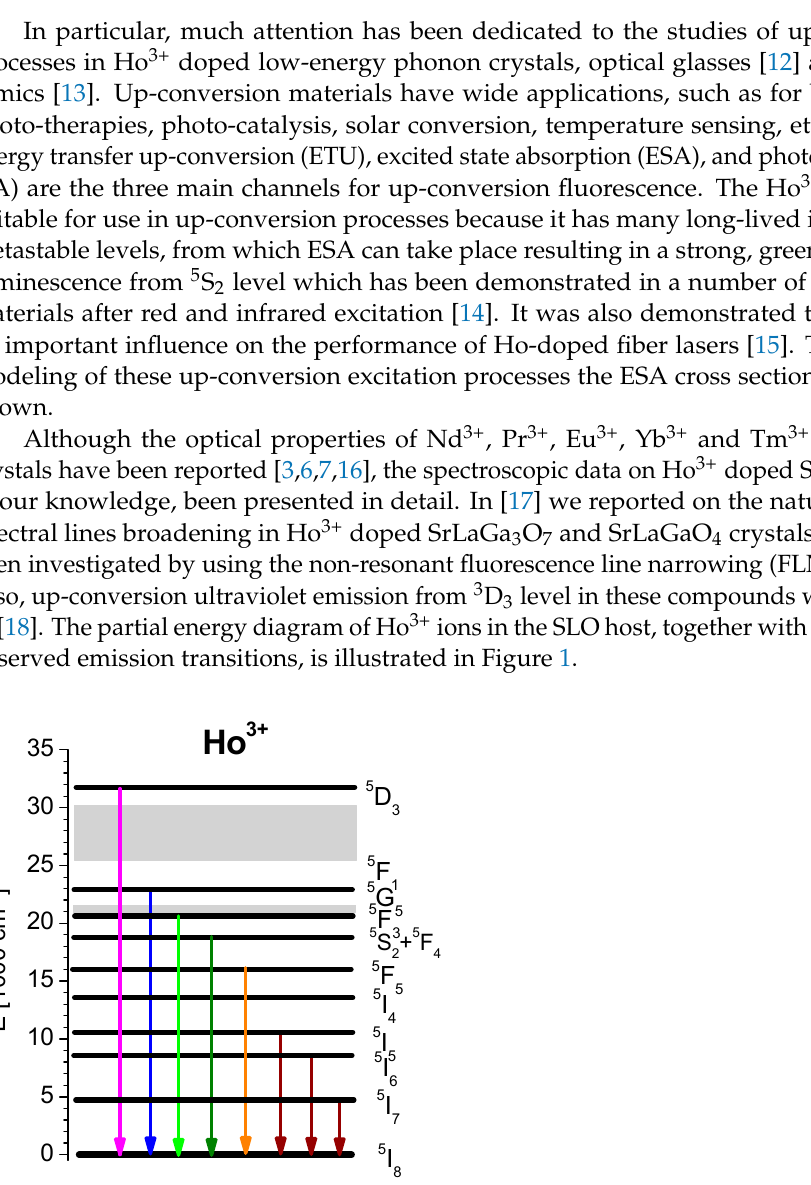
Figure 1. The partial energy diagram of Ho 3+ ions in SrLaGO 4 crystal. Arrows indicate the emission transitions.